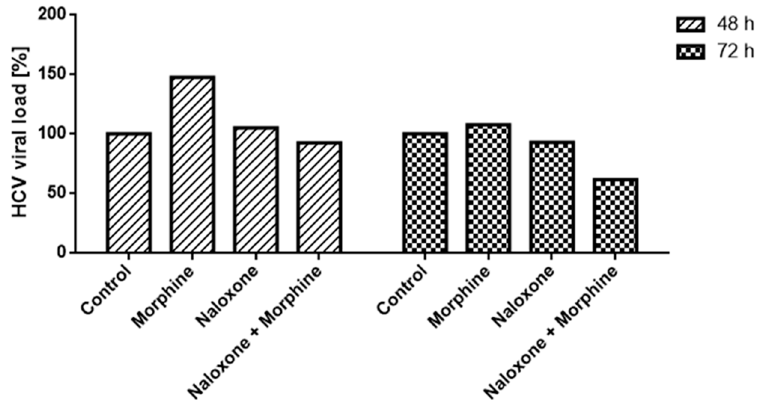
Figure 5. Effect of morphine (1.00 µM), naloxone (0.01 µM), and the combination of both compounds on the viral load of HCV in Huh7.5 SG cells at 48 and 72 h.